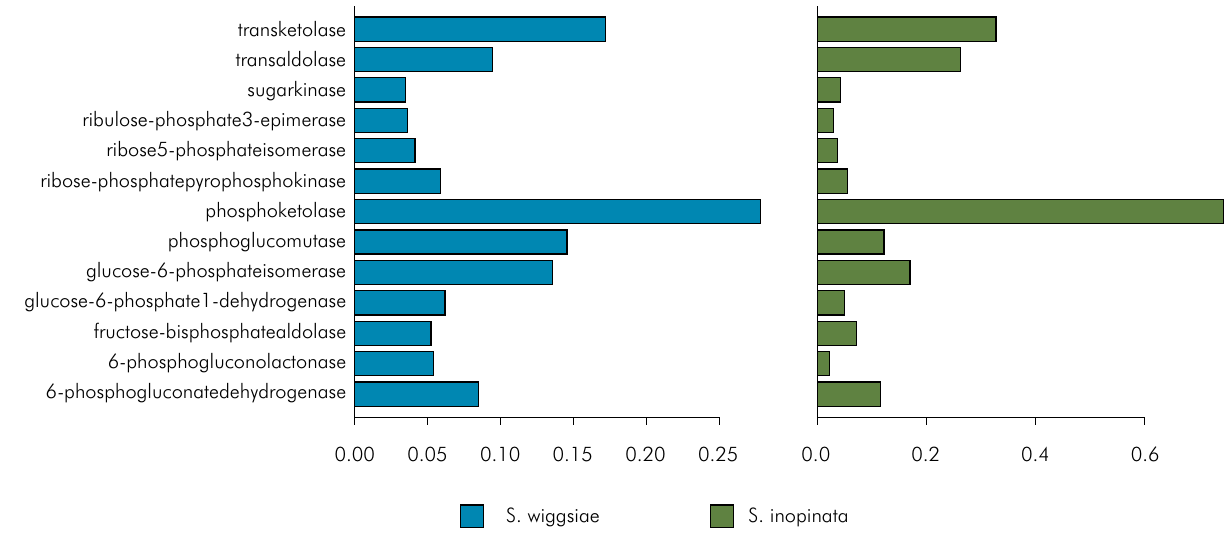
Figure 5. Proportion of reads assigned to genes that code Oxidative Pentose Phosphate Pathway enzymes in the transcriptome of Scardovia species. Median of gene expression at n = 8 samples with putative presence of